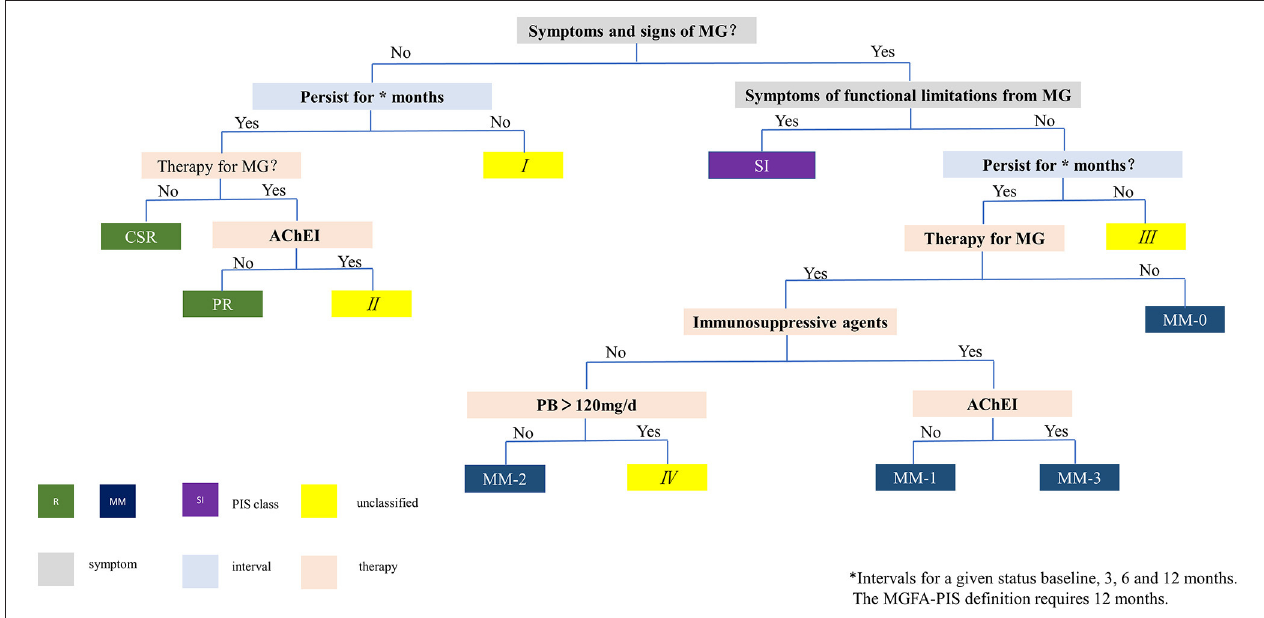
FIGURE 1 | Flowchart for PIS classification. I, III: unable to maintain requested intervals (3, 6 or 12 months), therefore cannot be classified. II: no symptoms, normal fatigue test, but still on oral PB, therefore does not meet the definition of R. IV: PB dose > 120 mg/d, therefore does not meet the definition of MM-2. MG, myasthenia gravis; PIS, post-intervention status; AChEI, acetylcholinesterase inhibitor; PB, pyridostigmine bromide; R, remission; CSR, complete stable remission; PR, pharmacological remission; MM, minimal manifestation; SI, slight impact on daily